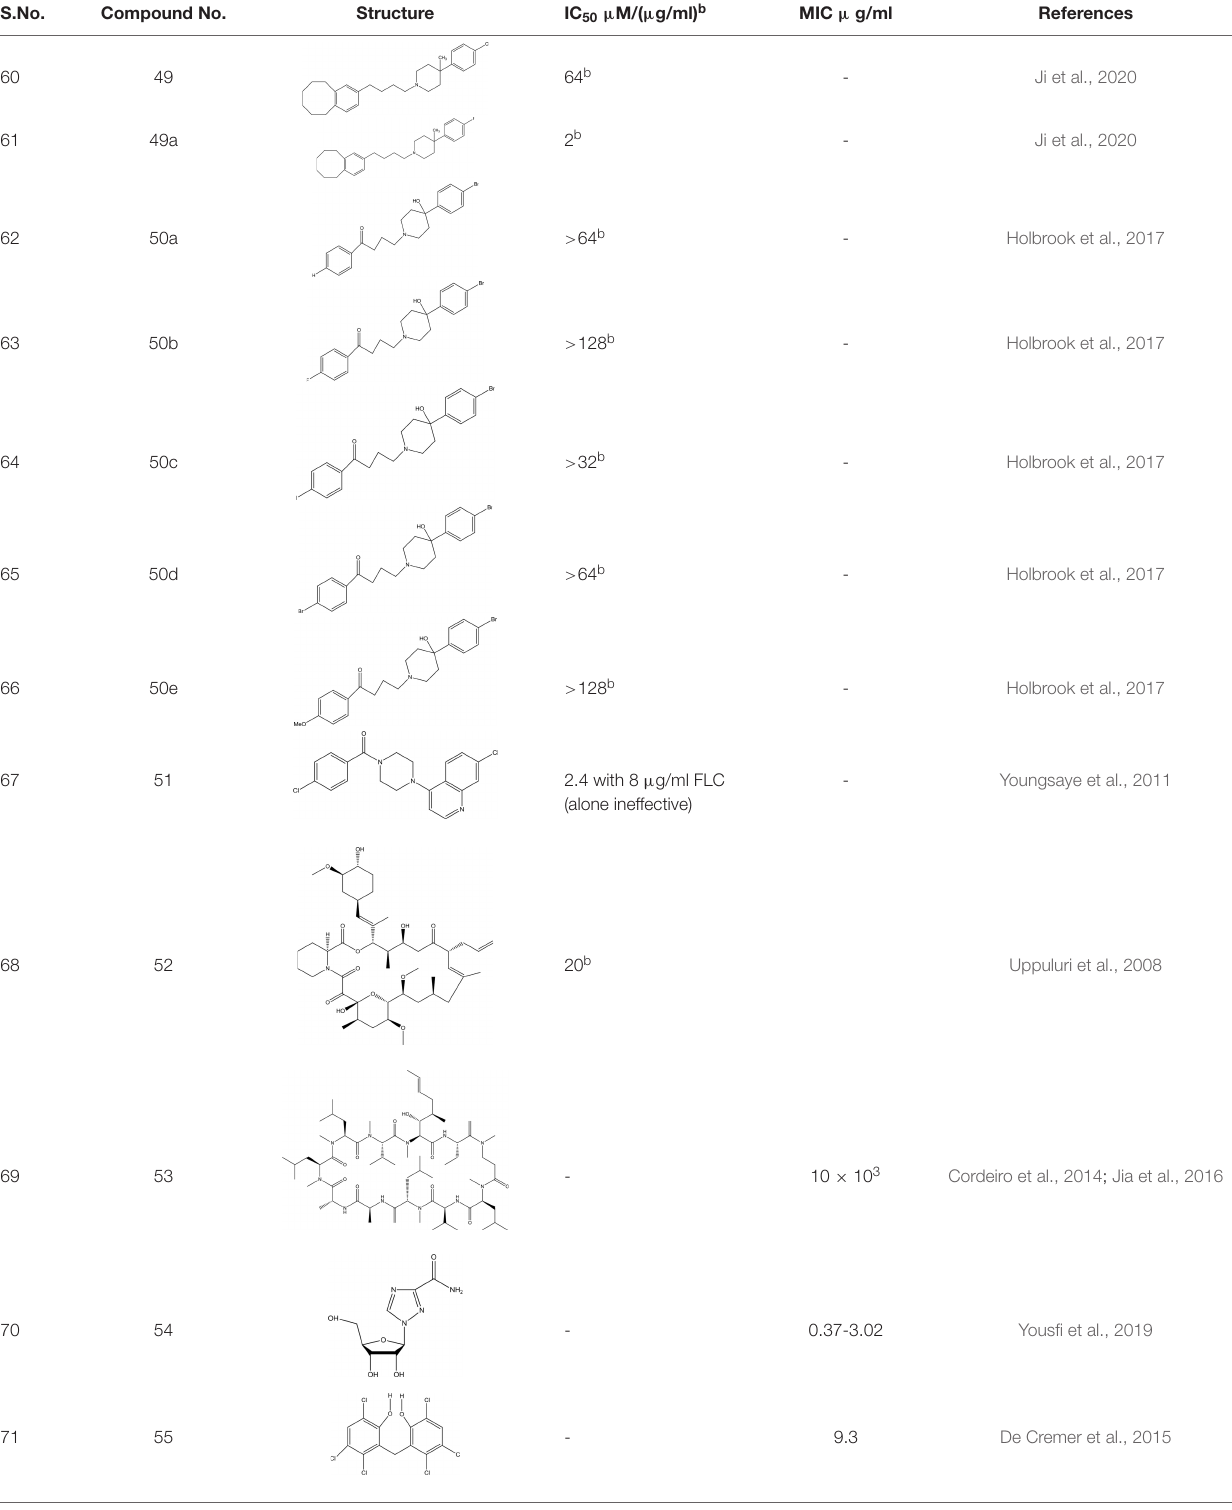
TABLE 4 | Chemical structures and MIC/IC 50 values of small molecule inhibitors (49–70). S.No. Compound